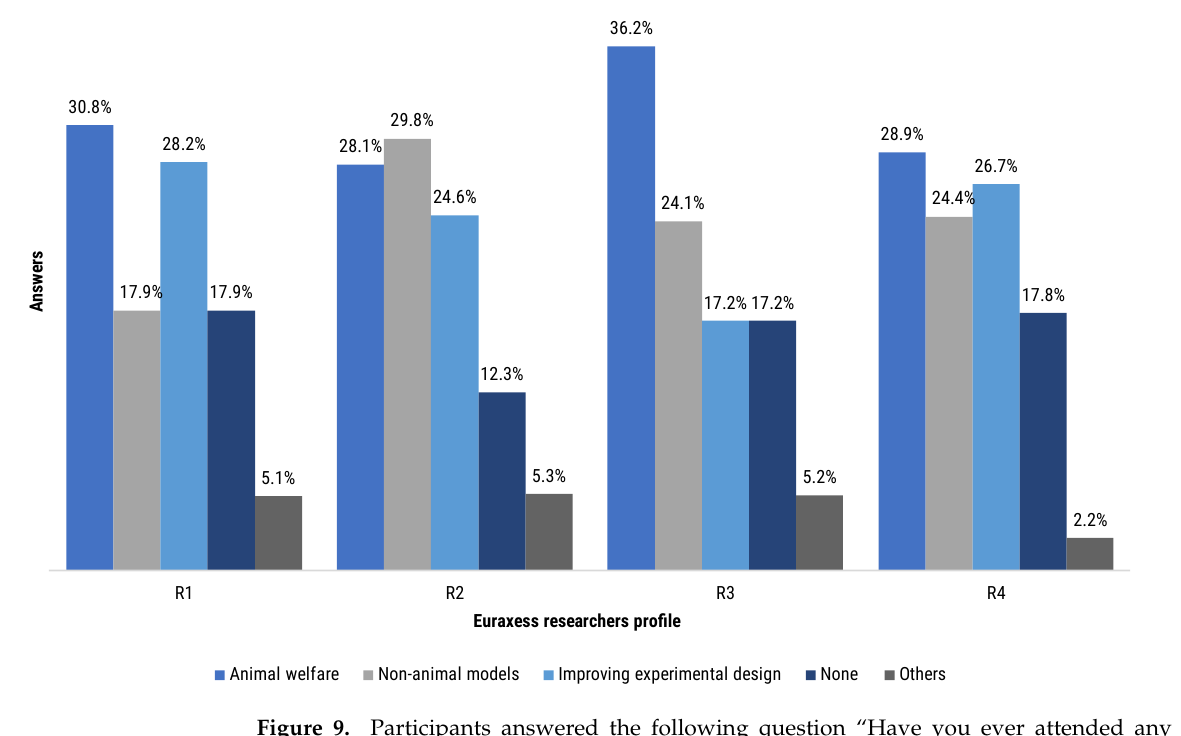
Figure 9. Participants answered the following question “Have you ever attended any work- shop/course on …?” by selecting closed options to choose from a list. The bar chart represents the distribution of answers regarding continuing education topic reported by each Euraxess research profile (the bar chart is normalised to the total answers per group: R1 = 39, R2 = 57, R3 = 58, R4 = 45).